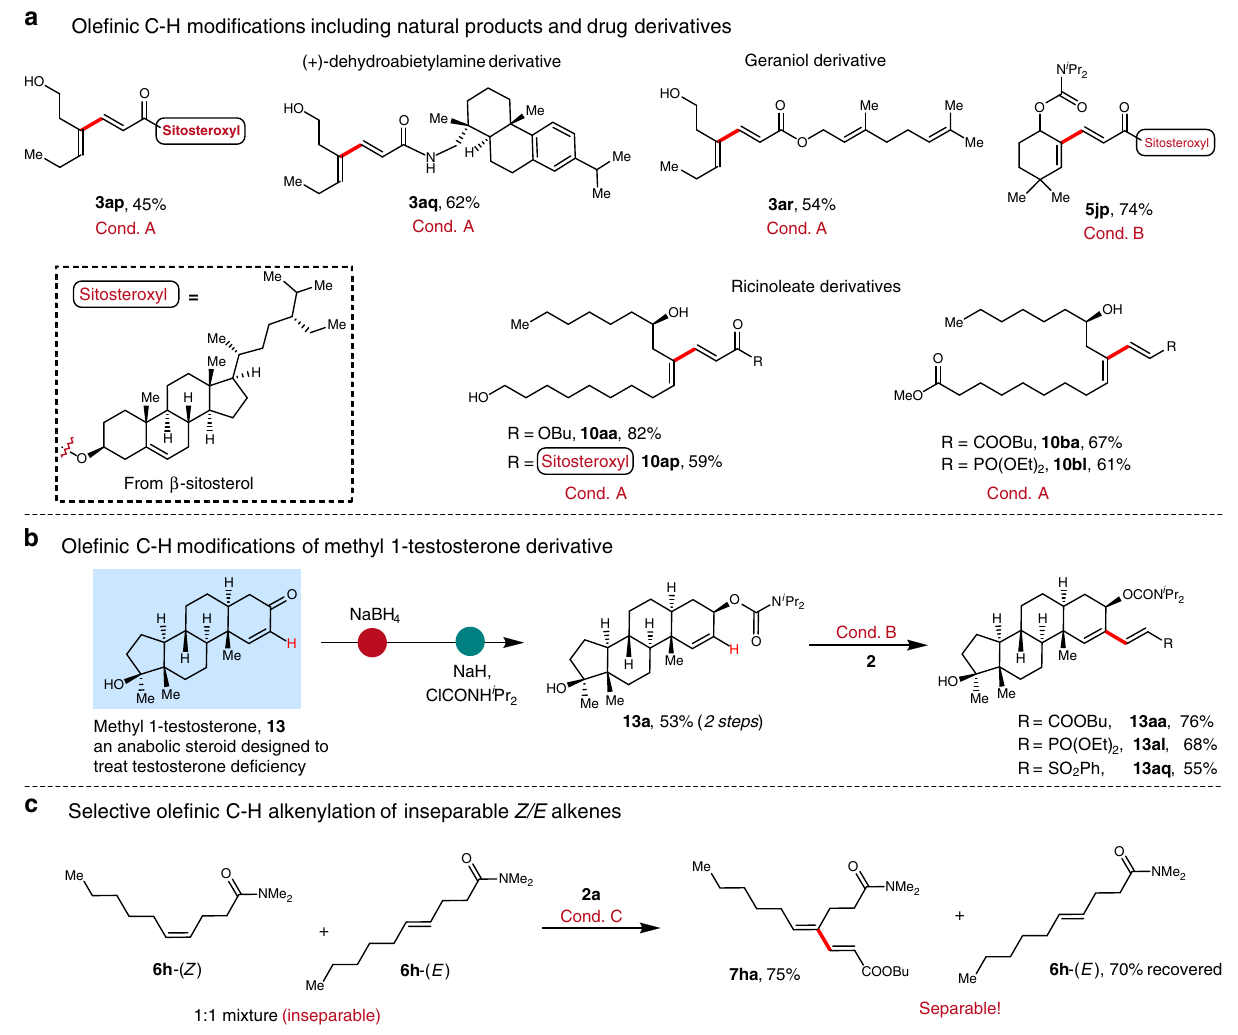
Fig. 4 Late-stage C – H functionalization of natural and pharmaceutical compounds. a Ole fi nic C – H modi fi cations including natural products and drug derivatives. b Ole fi nic C – H alkenylation of methyl 1-testosterone derivative. c Selective conversion of inseparable Z/E alkenyl